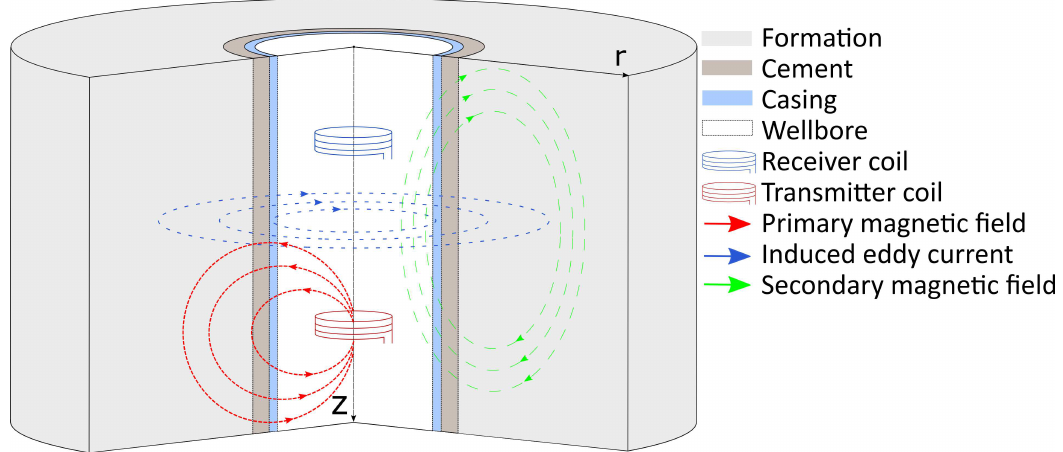
Figure 2. Schematic representation of an idealized geoelectric